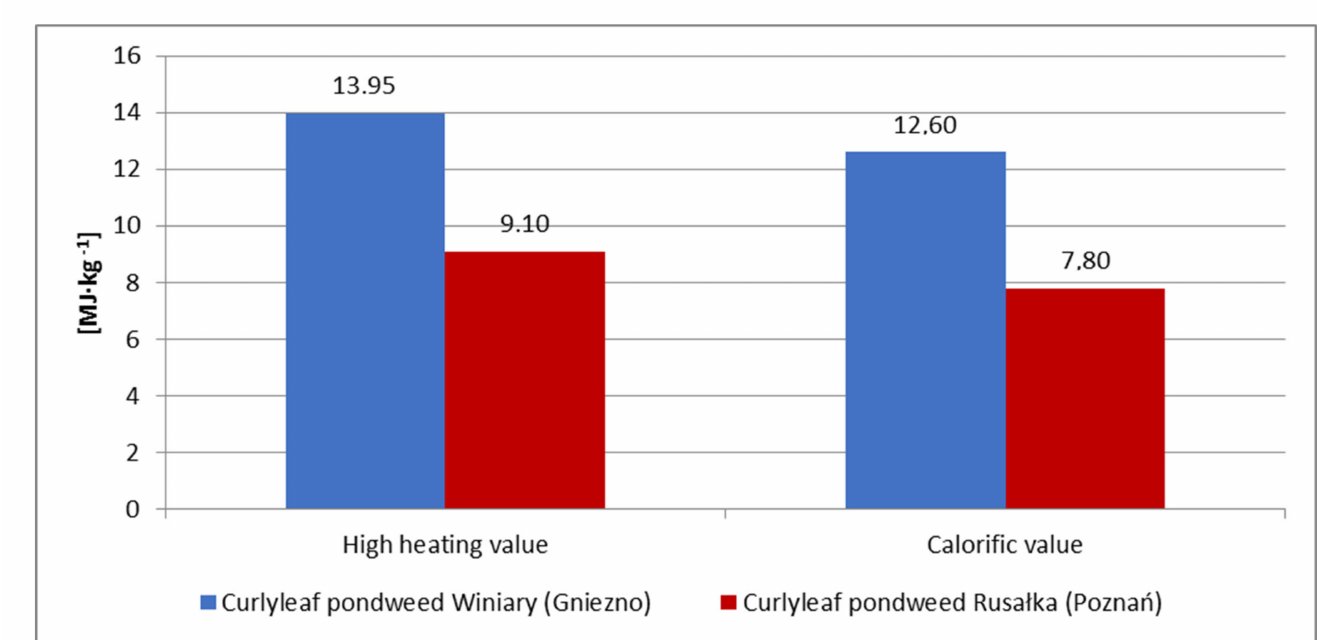
Figure 4. Combustion heat and calorific value of curly-leaf pondweed from Lake Winiary (Gniezno) and Lake Rusalka (Pozna´n).